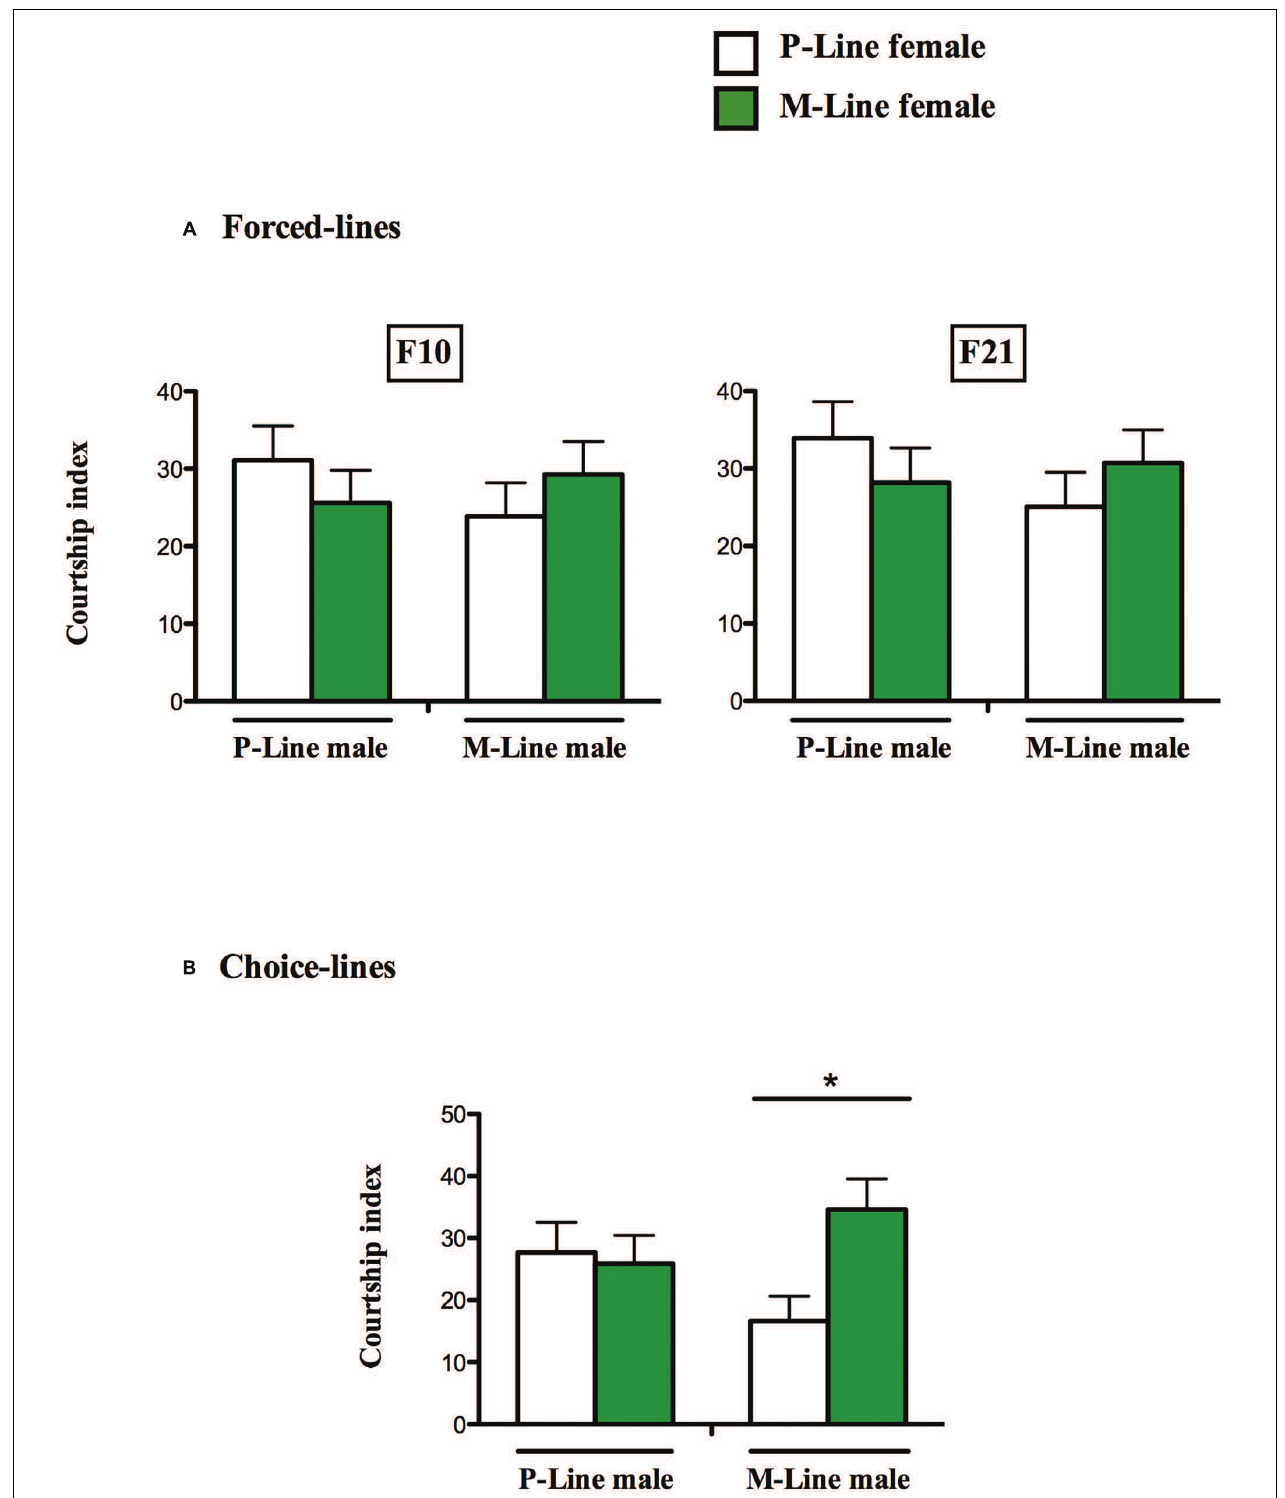
FIGURE 2 | Male discrimination in two differently exposed lines. Mean ( ± SEM) male courtship index to P-line (open bars) and M-line (green bars) target females. A pair of decapitated female flies (a P-line and a M-line female) was simultaneously presented to a single tester male, under red light, during a 5-min period. For each exposed line, Forced-line (A) and Choice-line (B) , the male ability to discriminate and court the two target females is shown above each pair of bars ( ∗ p < 0.05). (A) N = 32 (B) N = 56–65.